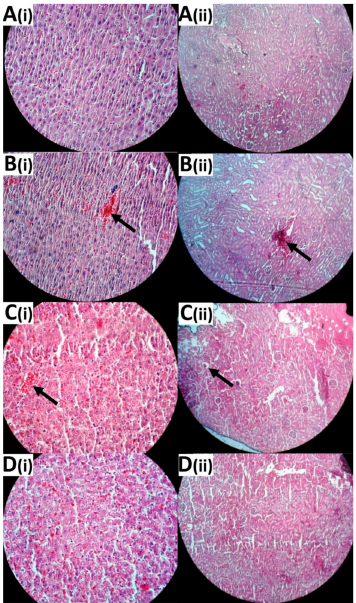
Figure 9. Histological evaluation of ( i ) liver and ( ii ) kidney tissues in ( A ) healthy rats, ( B ) BC-bearing rats receiving Cispt, ( C ) BC-bearing rats receiving LCispt, and ( D ) BC-bearing rats receiving PLCispt. The arrows show cell necrosis. Arrows show the pathological lesions (Magnification ×